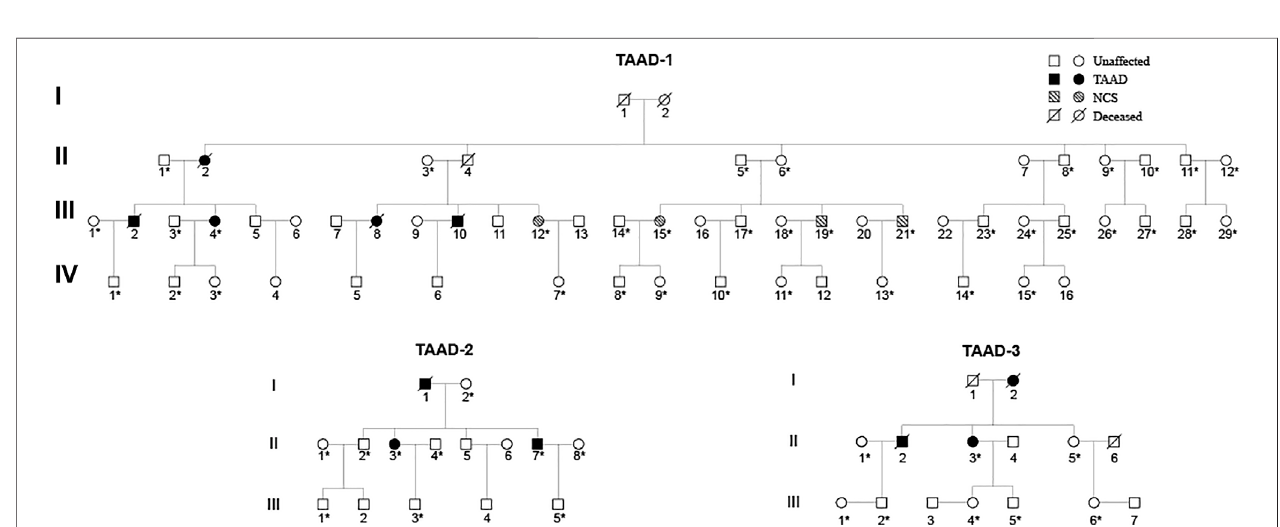
FIGURE 2 | Pedigrees of three unrelated TAAD families: TAAD-1, TAAD-2, and TAAD-3. Square and circle denote male and female, respectively. An asterisk indicates that these samples were whole-exome sequenced.